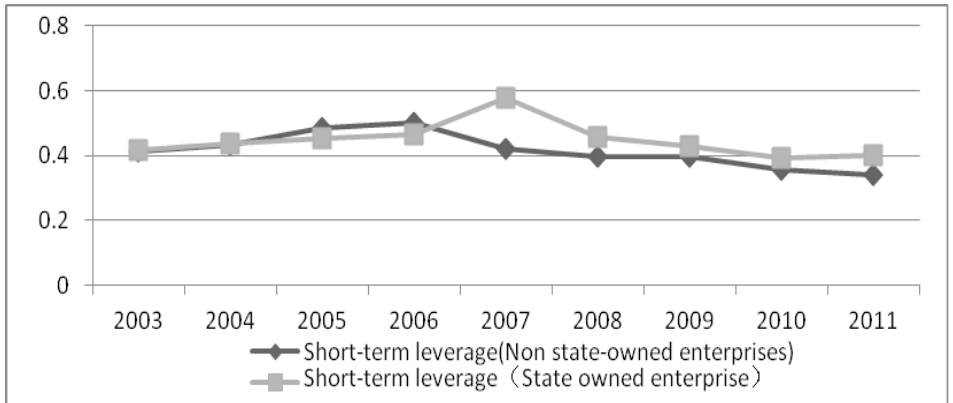
Figure 2. Short-term debt ratio of the state-owned enterprises and non-state-owned enterprises over the period 2003-2011